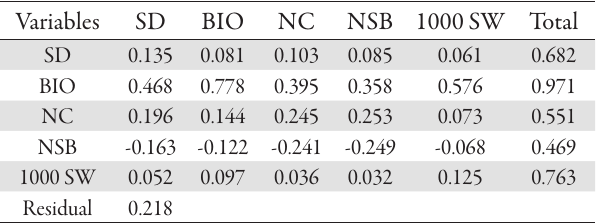
Tab. 2. Direct and indirect effects of black seed characters on seed yield under normal irrigation conditions